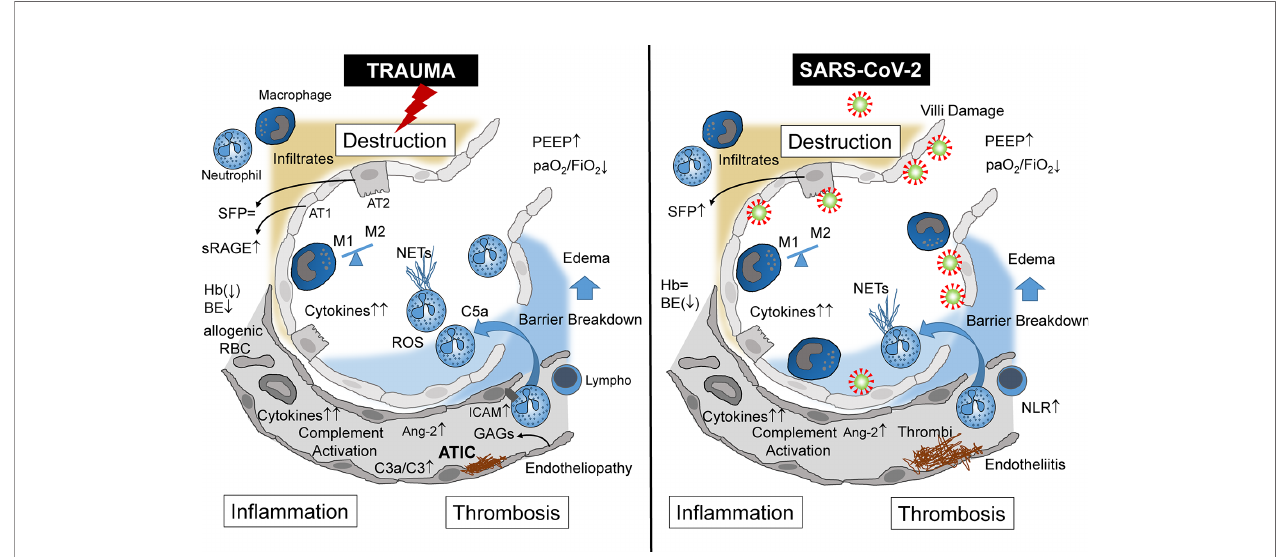
FIGURE 1 | Alveolar immunopathophysiology during ARDS caused by severe tissue trauma (left side) or by SARS-CoV-2 infection (right side) with subsequent destruction, in fl ammation, thrombosis, and destruction. ARDS, acute respiratory distress syndrome; NETs, neutrophil extracellular traps; NLR, neutrophil/lymphocyte ratio; AT1, alveolar type 1 cells; AT2, alveolar type 2 cells; Ang-2, angiopoietin 2; sRAGE, soluble receptor for advanced glycation end products; SFP, surfactant protein; Hb, hemoglobin; BE, base excess; RBC, red blood cells (transfusion); ATIC, acute trauma-induced coagulopathy; Lymph, lymphocyte; C3, complement component 3; C3a, activated complement 3 (anaphylatoxin); C5a, activated complement 5 (anaphylatoxin); PEEP, positive end-expiratory pressure; paO 2 , partial arterial oxygen pressure; FiO 2 , fraction of inspired oxygen; GAGs, glycosaminoglycans; ICAM, intercellular adhesion